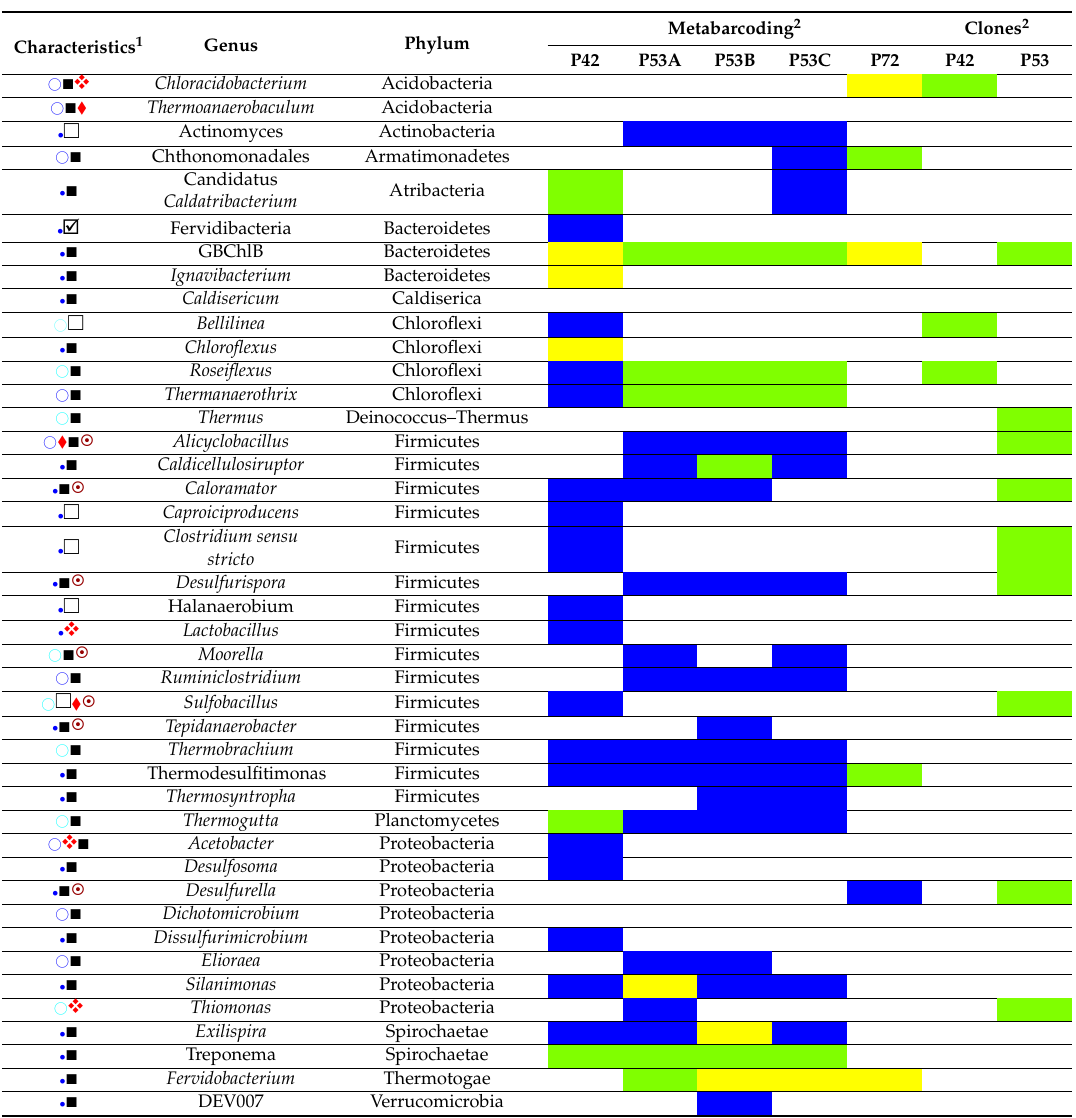
Table 2. Genera described as aerobic, anaerobic thermophilic, thermotolerant, acidophilic and or acidotolerant of the Lirima hot springs.